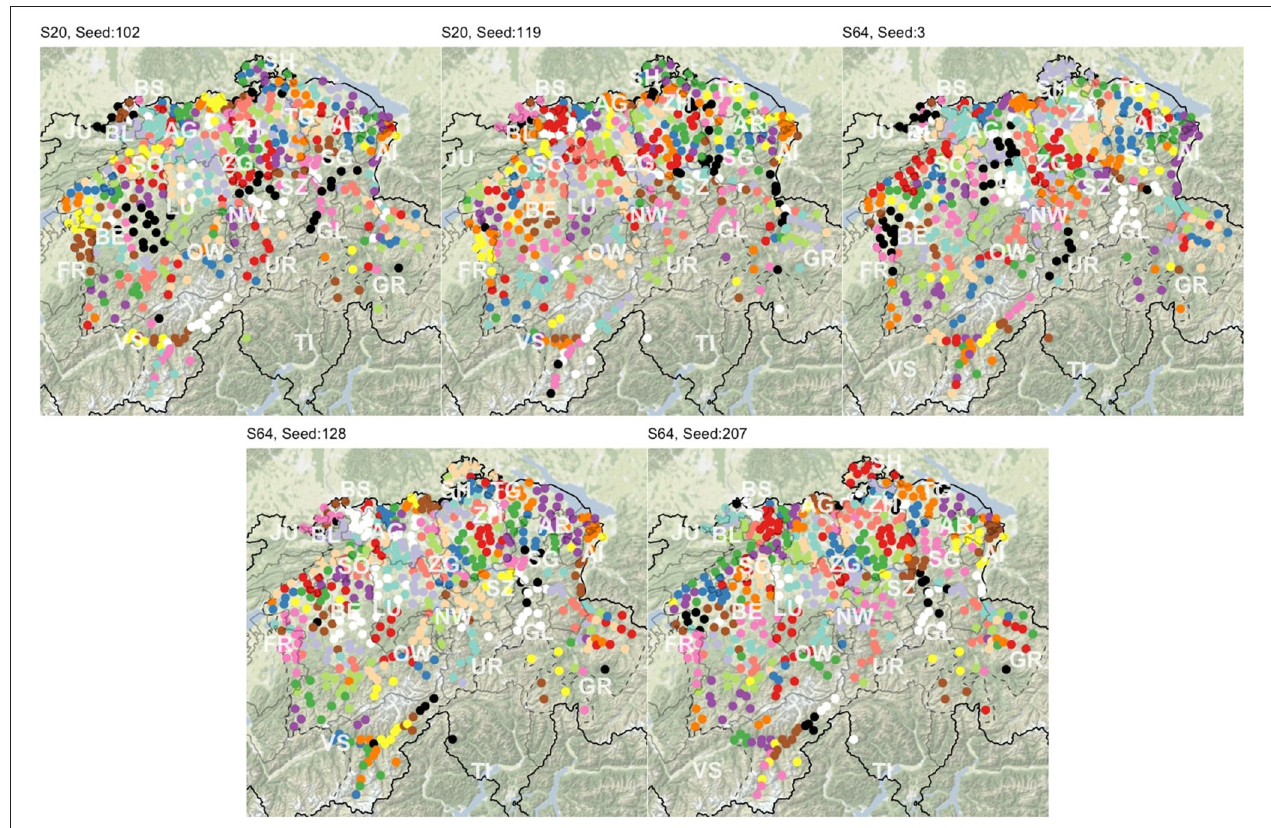
FIGURE 6 | Clusters resulting from five balanced random subsets of SDS variables. Clusters are presented on a diverging scale of 15 colors, which